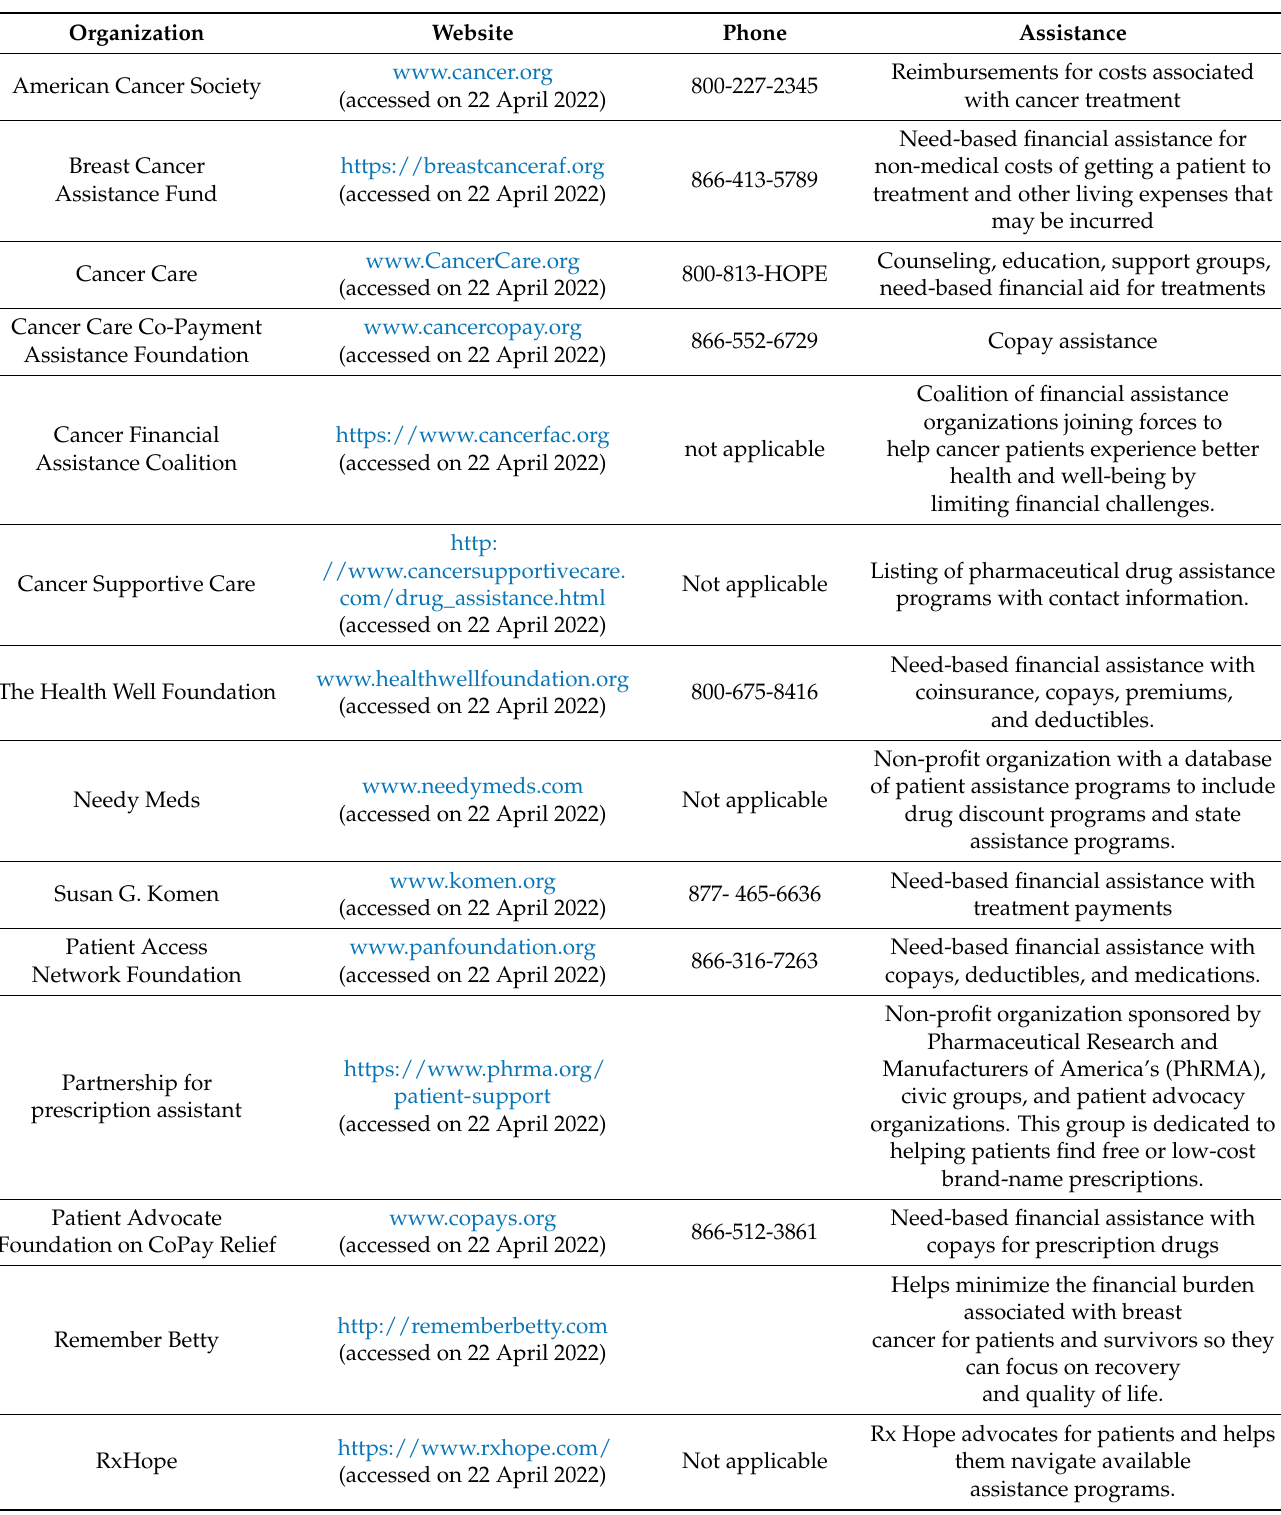
Table 1. Several financial assistance programs can allay financial strain resulting from extensive cancer therapy. However, many are geared toward short-term treatments provided for early-stage cancers. Here, we list resources tailored to assist with management of long-term cancer